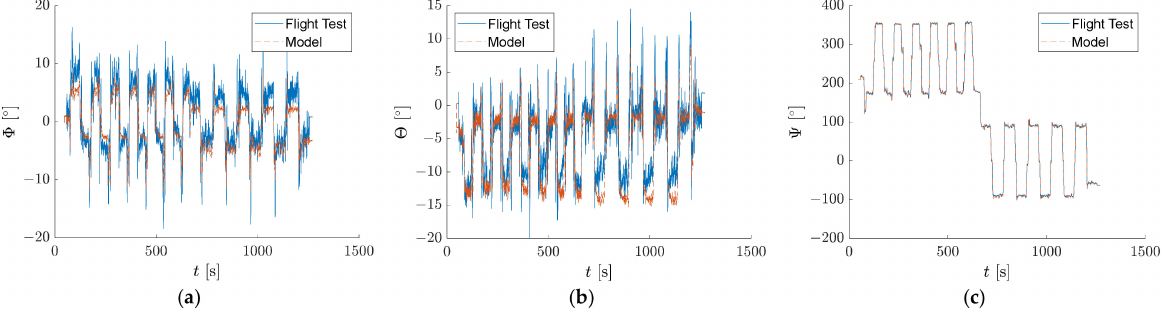
Figure 20. Euler angles: ( a ) roll, ( b ) pitch, and ( c ) yaw. The total flight time was 1271.55 [s]. Autopilot settings limited the maximum speed in the horizontal and vertical directions.